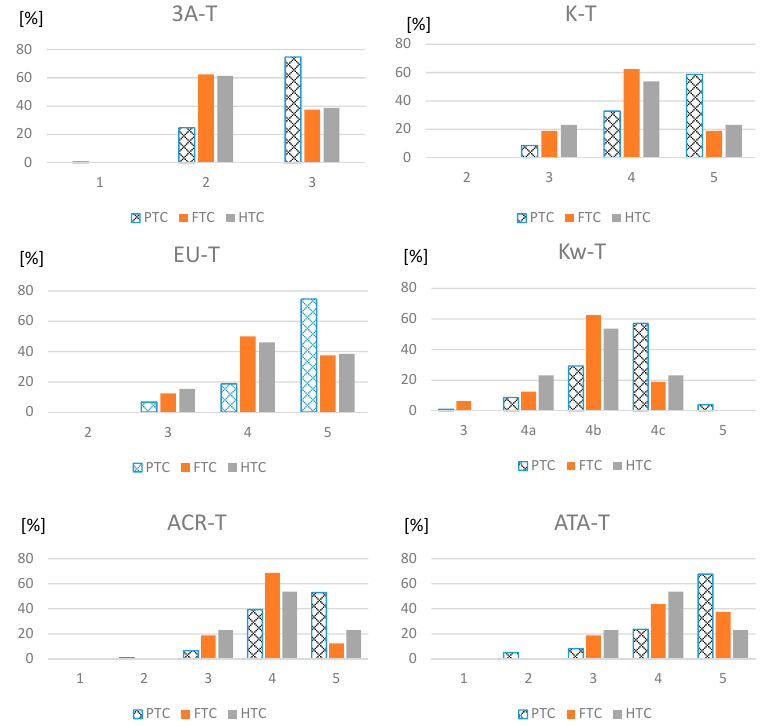
Figure 1. Distribution of papillary (PTC), follicular (FTC) and Hürthle cell (HTC) thyroid carcinomas among particular categories of evaluated TIRADS. 3A-T, American Association of Clinical Endocrinologists (AACE), American College of Endocrinology (ACE) and Associazione Medici Endocrinologi (AME) Thyroid Imaging Reporting and Data Systems; K-T, Korean Thyroid Imaging Reporting and Data Systems; EU-T, European Thyroid Association TIRADS; Kw-T, Kwak Thyroid Imaging Reporting and Data Systems; ACR-T, the American College of Radiology Thyroid Imaging Reporting and Data Systems); ATA-T, American Thyroid Association.